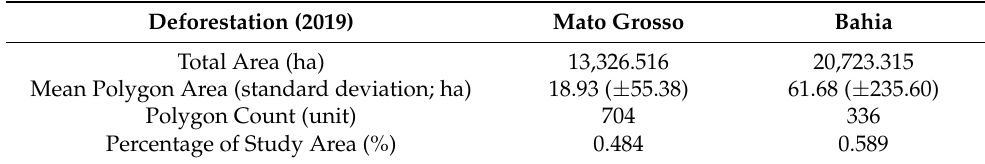
Table 1. Deforestation statistics for 2019 in the study areas (main and auxiliary). Source: adapted from [11]. Deforestation (2019) Mato Grosso Bahia Total Area (ha) 13,326.516 20,723.315 Mean Polygon Area (standard deviation;